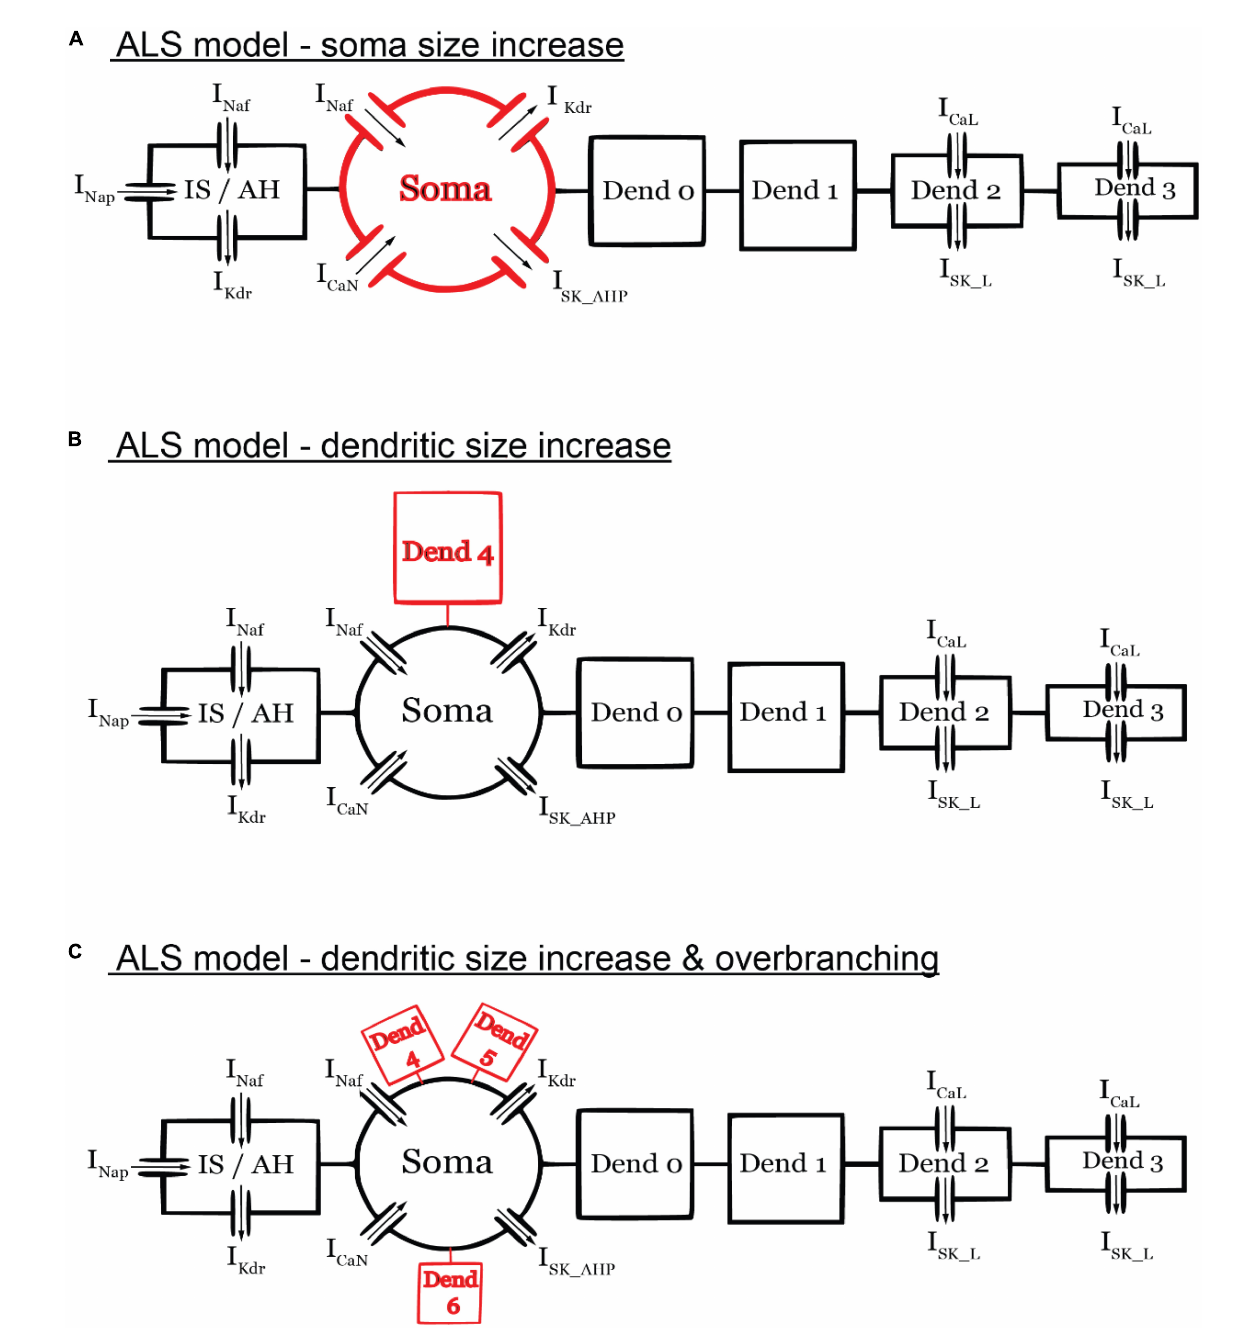
FIGURE6 Schematic diagrams of the ALS models. (A) ALS model with only soma size increased (by 10%). (B) ALS model with only dendritic size increase (by 30%) via the addition of one dendritic branch. (C) ALS model with only dendritic size increase (by 30%) via the addition of three dendritic branches. The diagrams are not to scale. All other model parameters were unchanged in the ALS